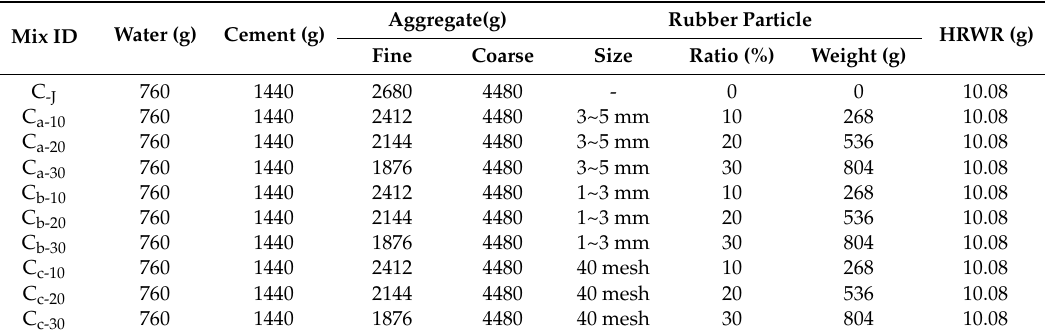
Table 3. Mix identifications and ratios of cubic